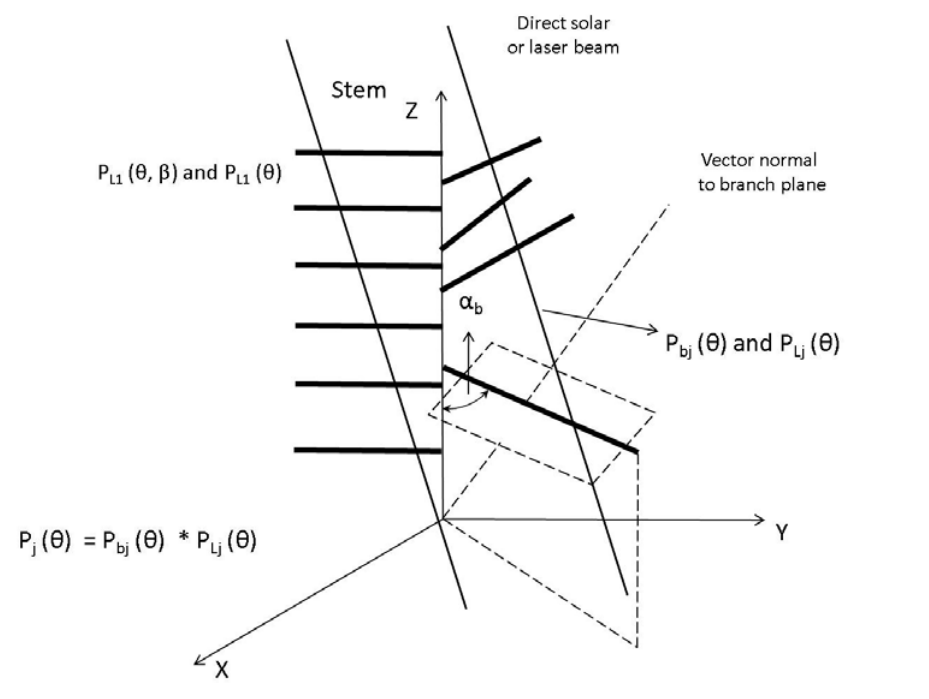
Figure 3. Schematic diagram illustrating the multi-layer theoretical model to calculate the gap